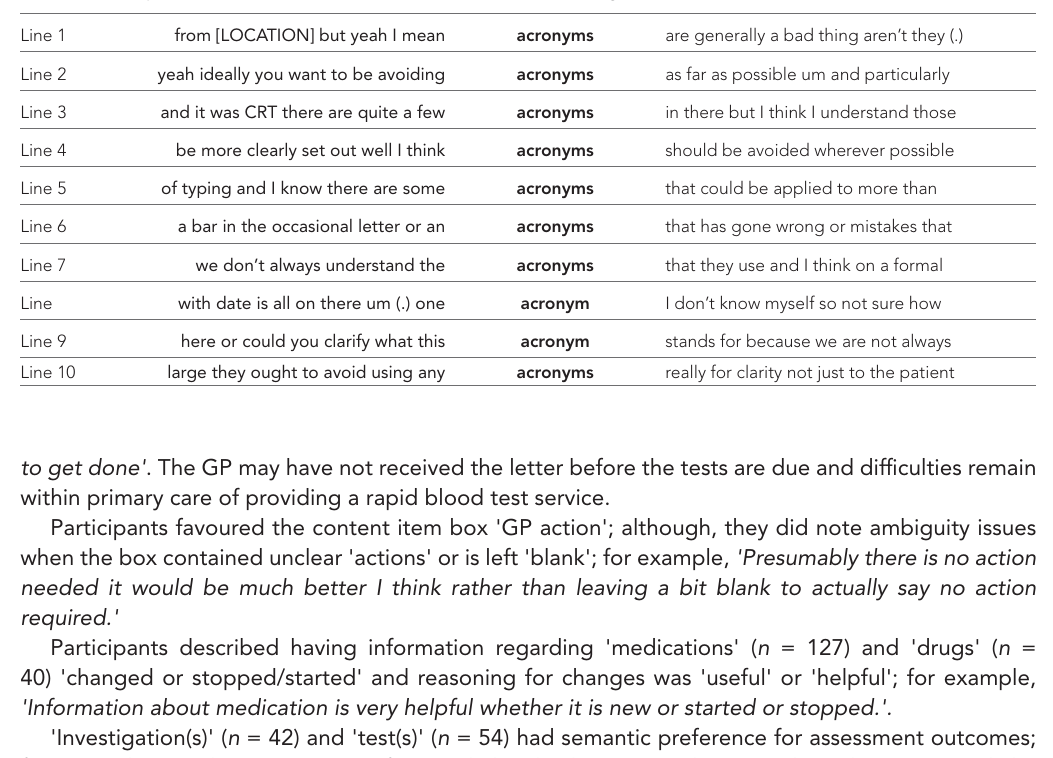
Table 2 Sample of 10 random concordance lines for